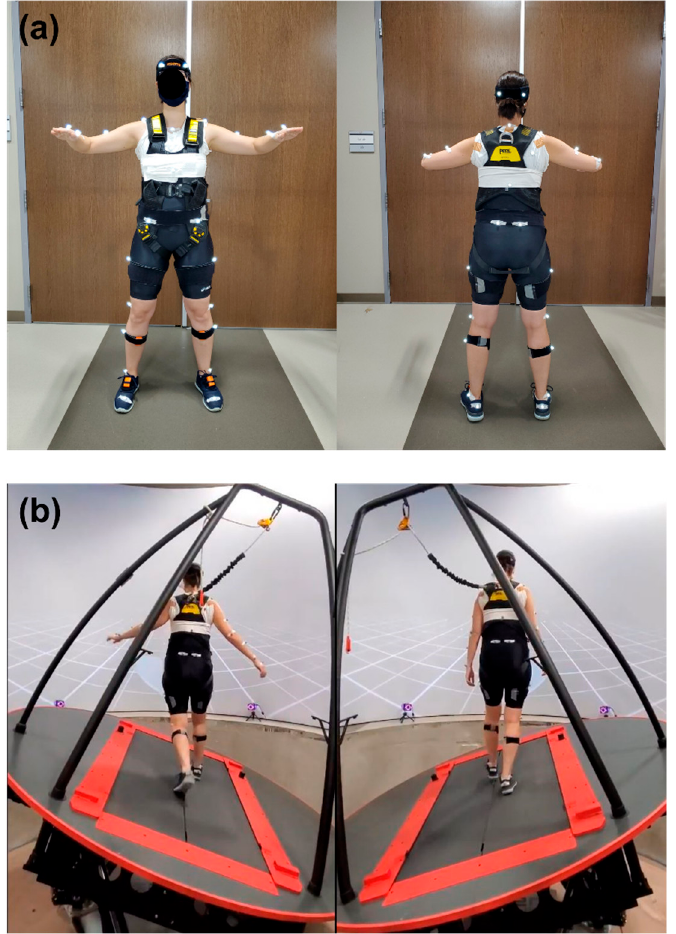
Figure 1. Experimental settings: ( a ) placement of reflective markers and IMU sensors; ( b ) example of simulated roll.